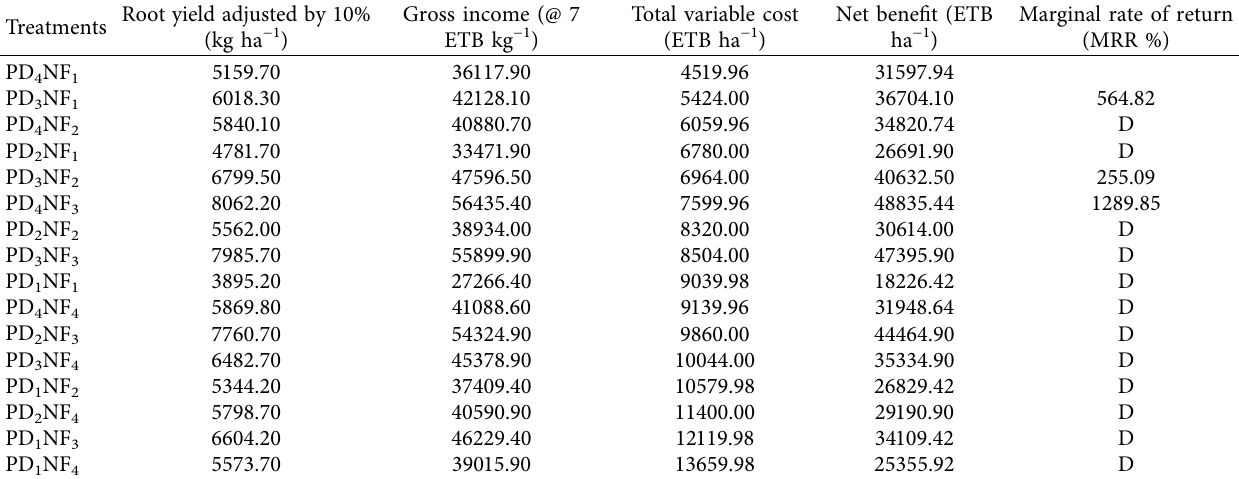
Table 3: Economic analysis for the effect of plant density and nitrogen fertilizer rates on beetroot. Root yield adjusted by 10% Treatments (kg ha − 1